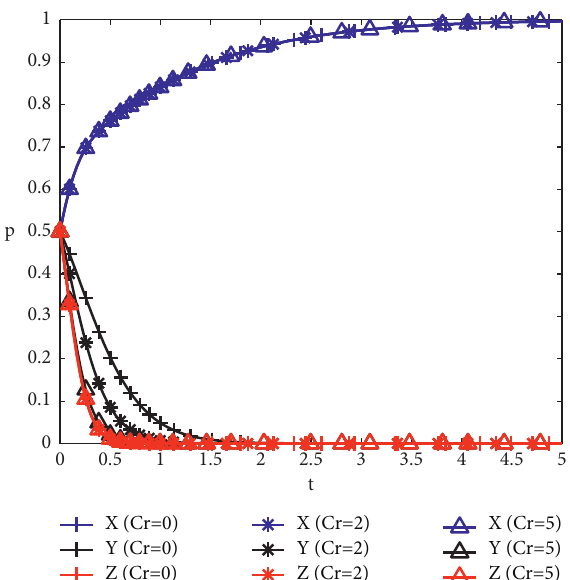
Figure 10: Evolution path under different effect’s increasing multiples.